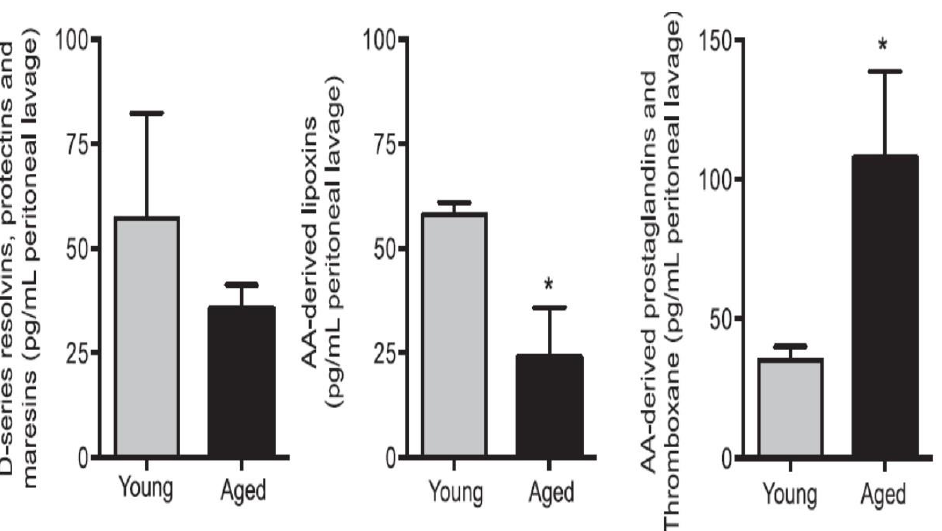
Figure 5. Aged mice show reduced resolvins, protectins and maresins and LXA4 in the peritoneal lavage of zymosan challenged animals. * p < 0.05 compared to young mice. This data is taken from reference no. 73.